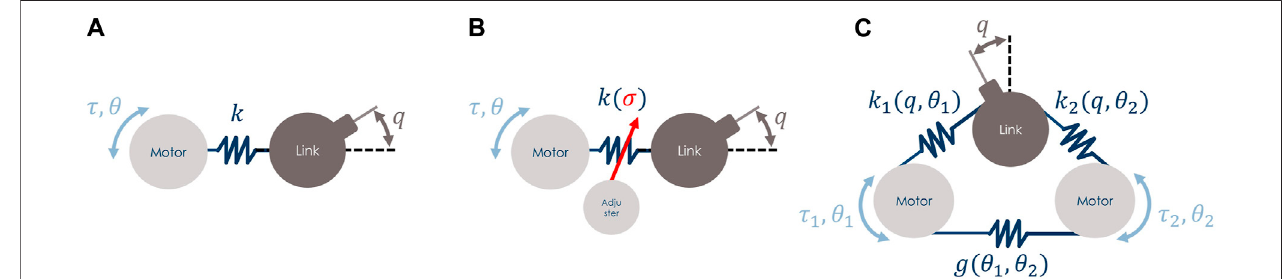
FIGURE2| ExamplesofcompliantactuatorschemesthatcanbesimulatedwiththeproposedROS-Gazebotoolbox, (A) isaSEAtype,while (B) and (C) areVSAs. The latter two differ for the variable stiffness principle, (B) implements a VSA with Adjuster, while (C) shows a VSA with Agonistic-Antagonistic (A – A) motor-coupled